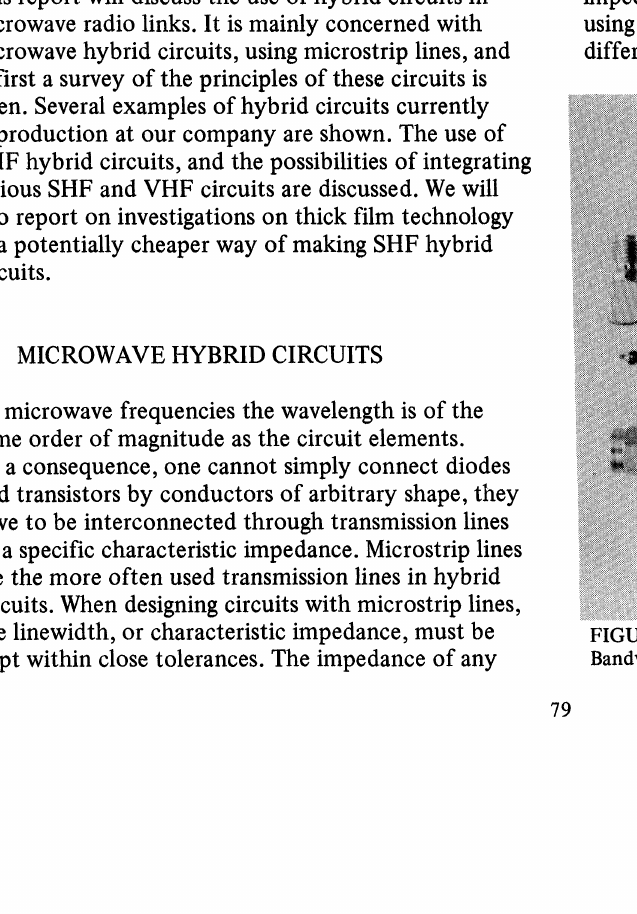
FIGURE High power amplifier. Output power 5W, Bandwidth 10%. Centre frequency 2